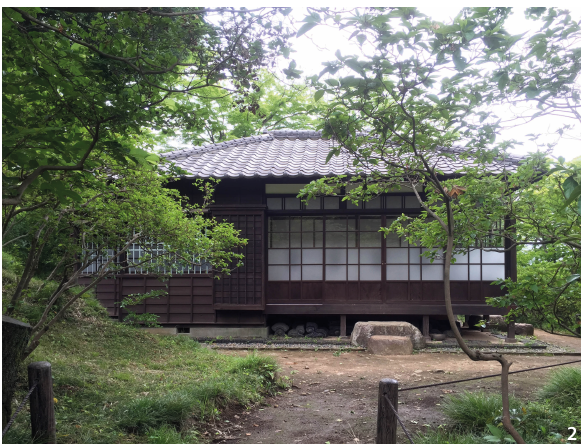
Figure 2 Taut’s home—Senshintei—in Takasaki (Source: Marco Capi-